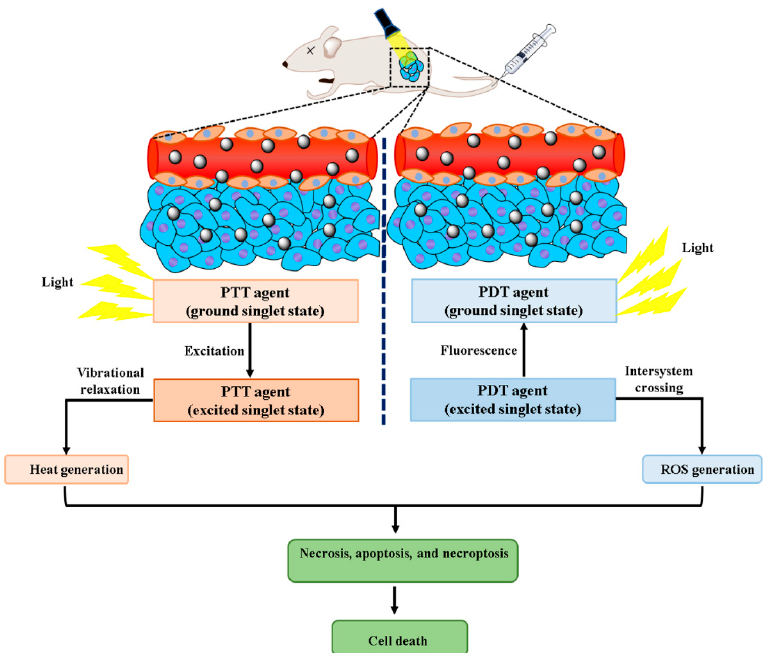
Figure 2. Illustration depicts the utilization of cancer nanomedicine in photothermal therapy (PTT) and photodynamic therapy (PDT) leads to cancer cell death.